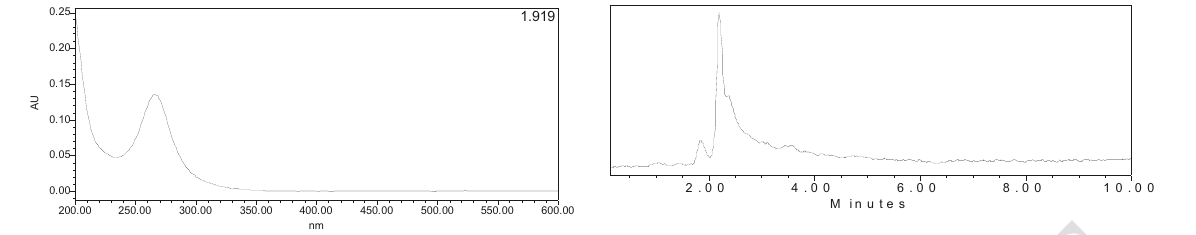
Figure 8. The UV-Vis spectrum of KGN after 2 h of irradiation with H